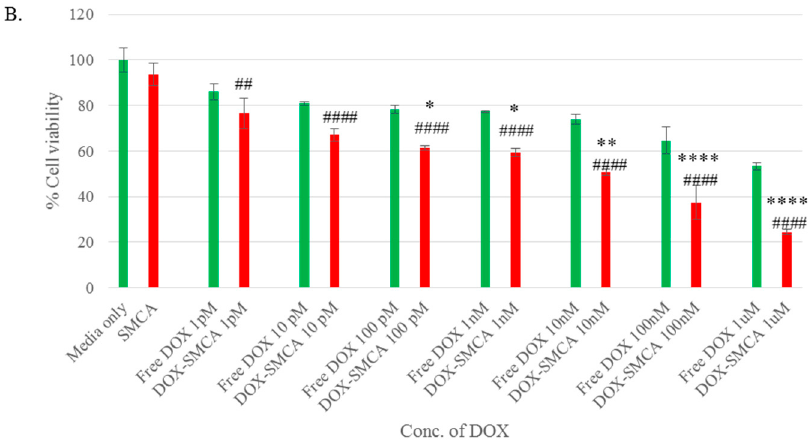
Figure 7. Cytotoxicity assay of DOX-loaded SMCA NPs. ( A ) cell viability assessment by MTT assay after 48 h incubation of the free DOX and DOX-loaded SMCA NPs with MCF-7 cell line; ( B ) cell viability assessment by MTT assay after 48 h incubation of the free DOX and DOX-loaded SMCA NPs with 4T1 cell line. Values were significant (*) at p -value 0.01 to 0.05, very significant (**) at p -value 0.001 to 0.01, highly significant (***) at p -value 0.0001 to 0.001, extremely significant (****) at p -value < 0.0001 vs. same treatment of free DOX. Values were significant (#) at p -value 0.01 to 0.05, very significant (##) at p -value 0.001 to 0.01, highly significant (###) at p -value 0.0001 to 0.001, extremely significant (####) at p -value < 0.0001 vs. untreated cells at CI of 95%.